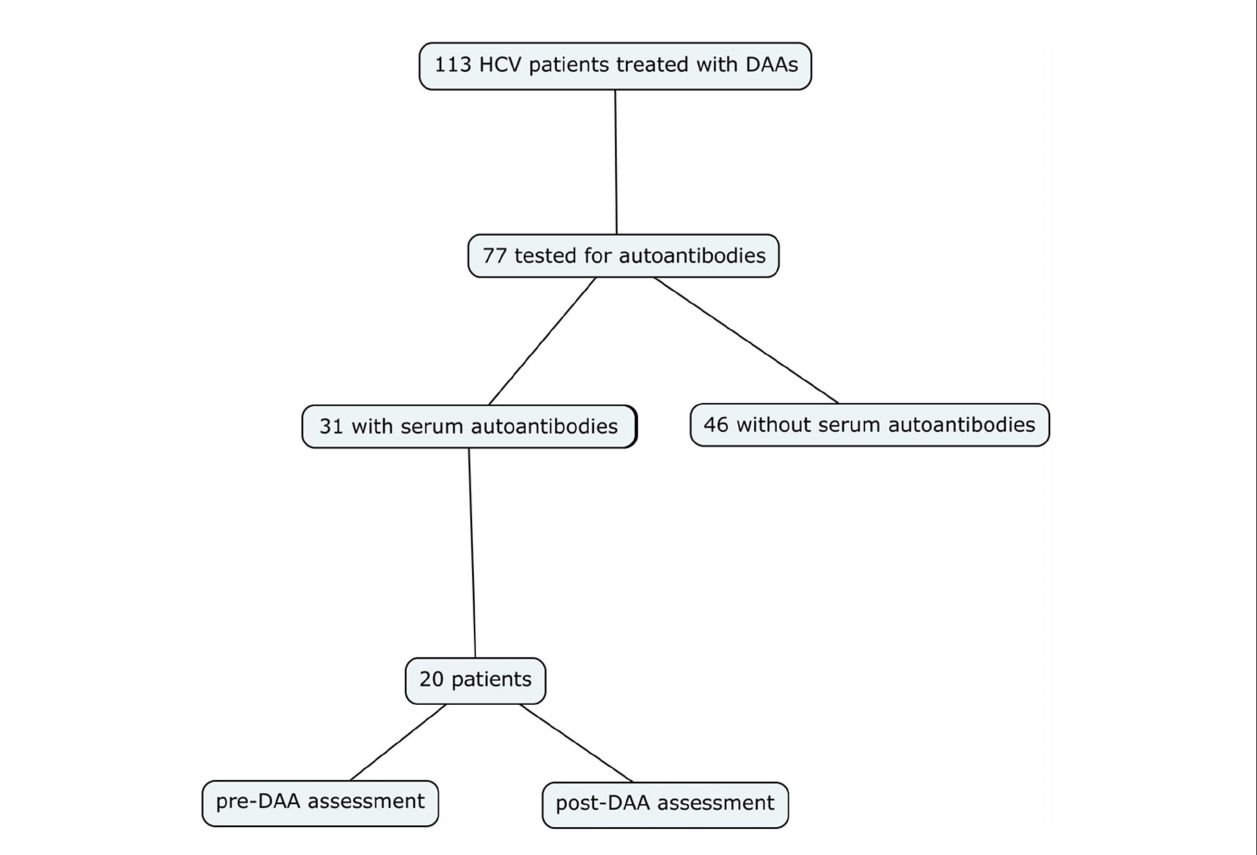
FIGURE 1 | Patient recruitment